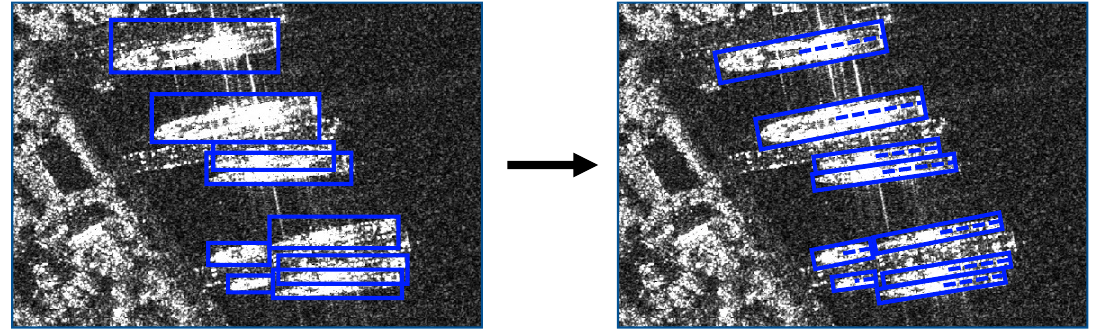
Figure 9. The difference between two kinds of labels.